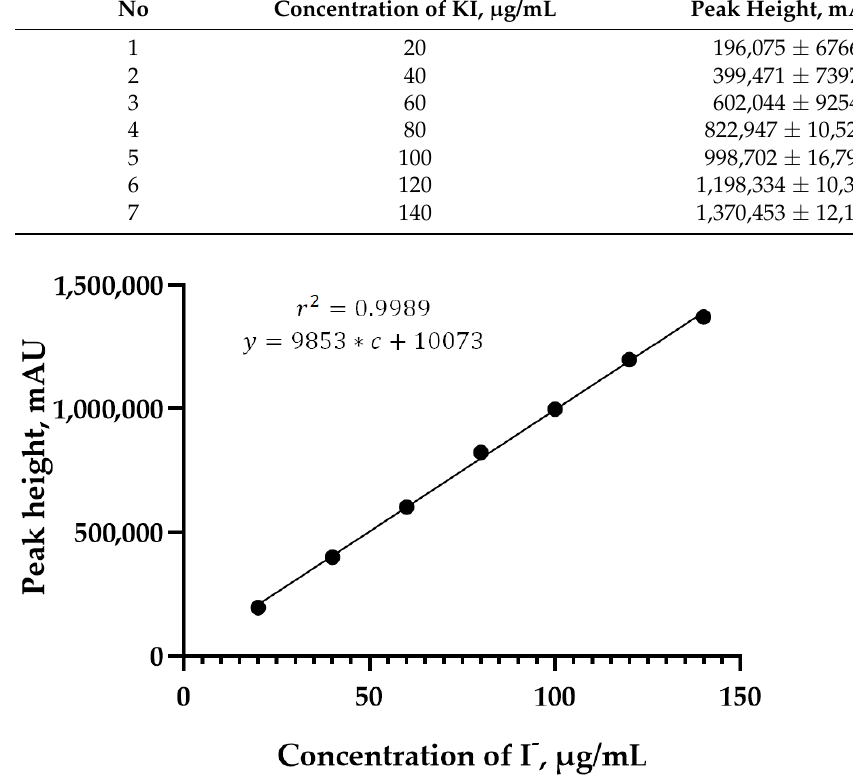
Figure 3. The dependence of peak height on the concentration of iodide.